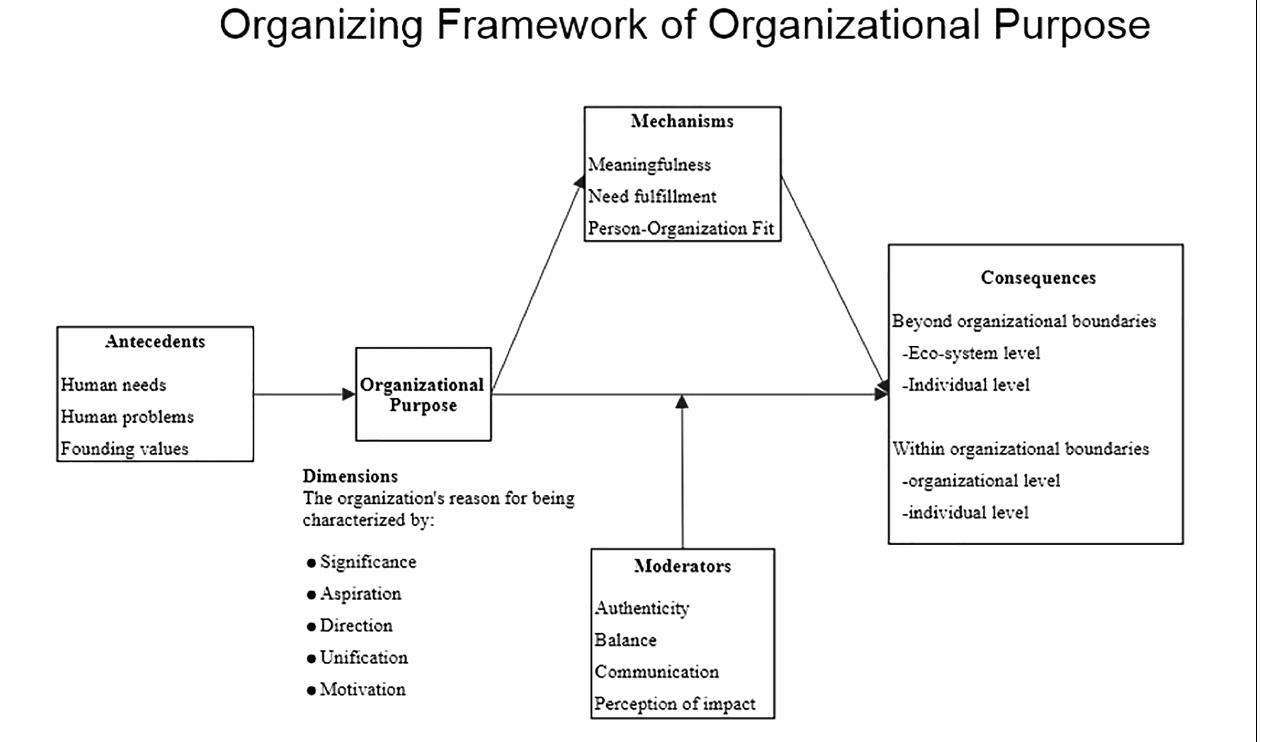
FIGURE 2 | Organizing framework of organizational